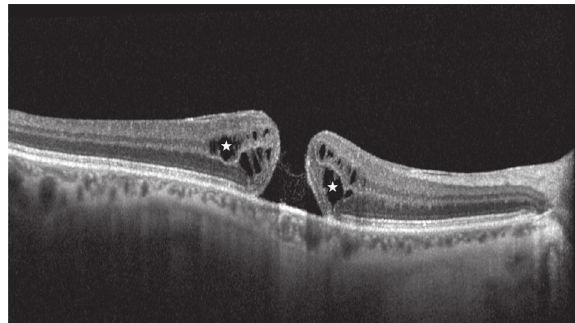
Figure 1: SD-OCT scan of a full-thickness macular hole (FTMH). In this scan, the white stars highlight the presence of intraretinal cysts of edema. In this image, there is a complete absence of the Muller cone complex and the vitreous is totally detached and not